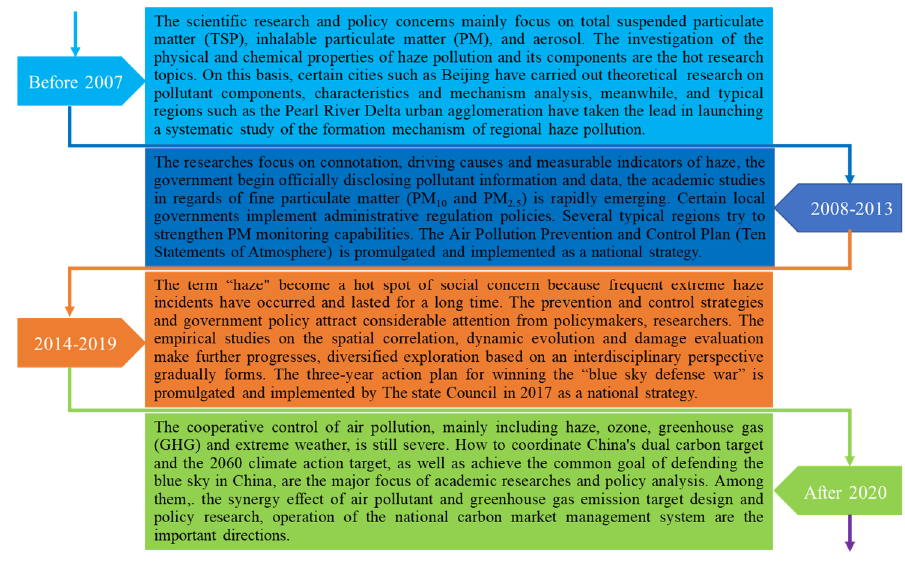
Figure 4. The evolution over time of research on China’s haze pollution.